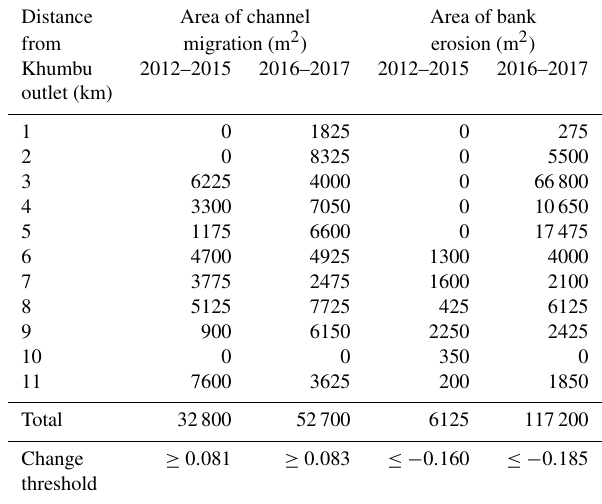
Table 2. Areal changes along the Khumbu proglacial stream preced- ing (2012–2015) and encompassing (2016–2017) the lake outburst. Channel migration refers to the change in wetted area determined by NDWI thresholding, and bank erosion corresponds to the removal of vegetation in the channel area, identified by large NDVI differ- ences. Distance